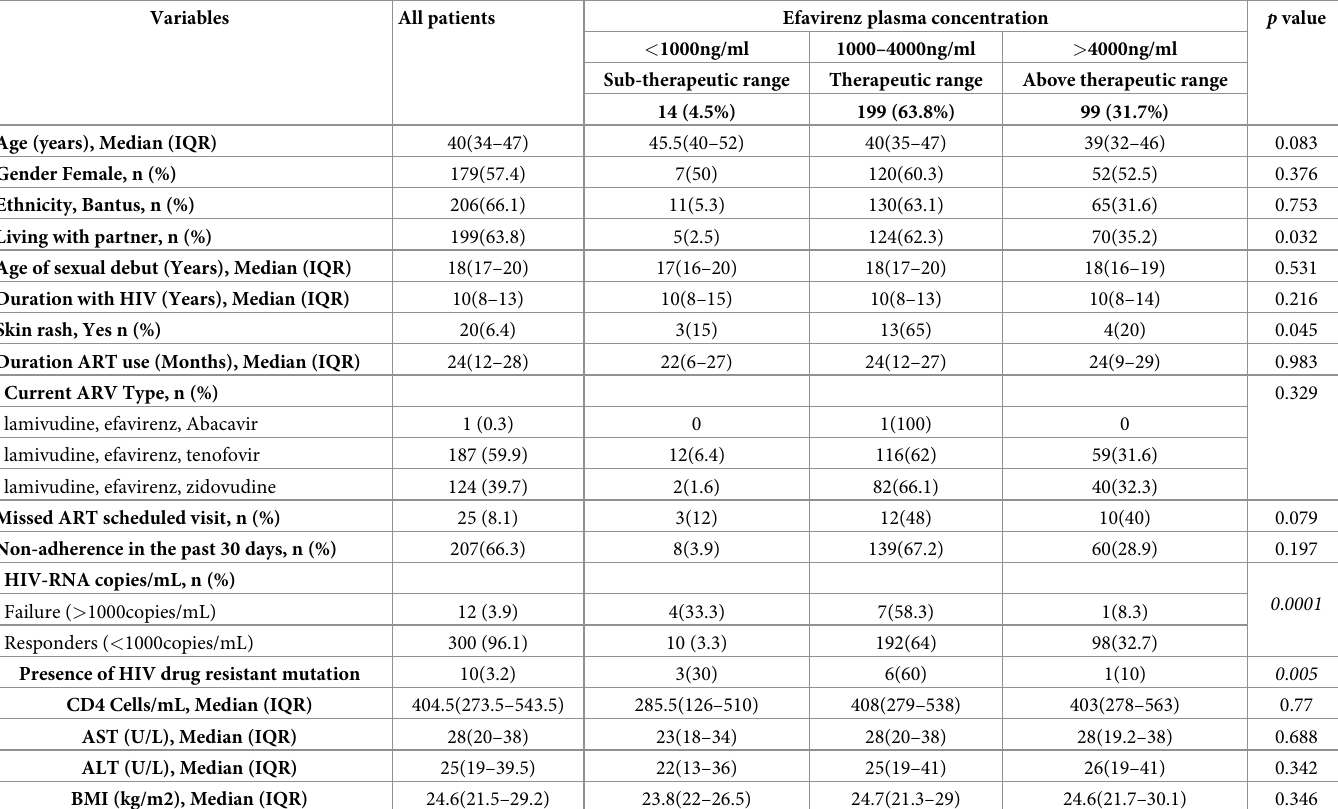
Table 2. Summary of patient demographics and clinical characteristics of